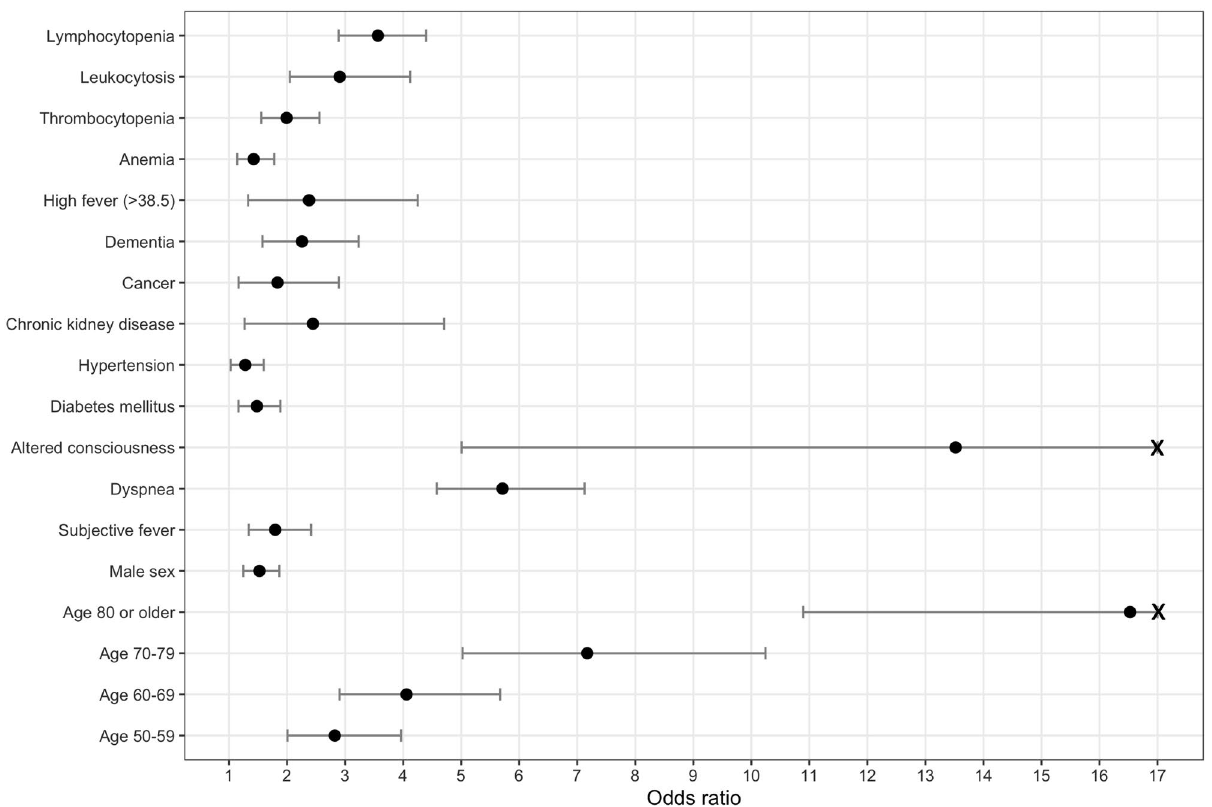
Figure 1. Forest plot showing the odds ratios of final predictors from multivariable ordinal logistic regression. The horizontal error bars indicated 95% confidence intervals. Note that the upper limit of 95% confidence interval is truncated for altered consciousness and age > 80. Detailed results are presented in Supplementary Table S4, including the odds ratios with confidence intervals from univariable and multivariable regression analyses.